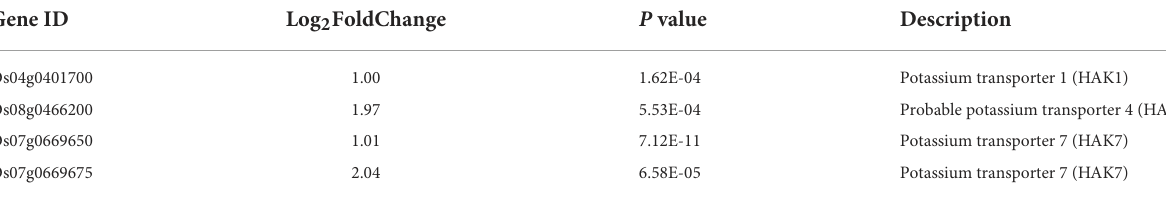
TABLE 3 Specifically regulated K + transporter genes only at 5 days after salt treatment. Gene ID Log 2 FoldChange P value